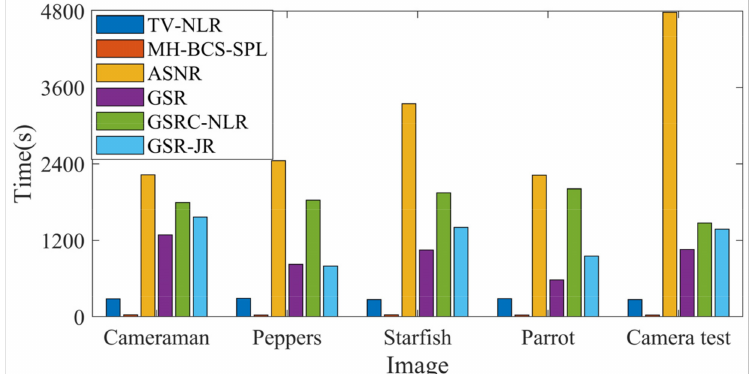
Figure 10. The reconstruction time for the various model at R =